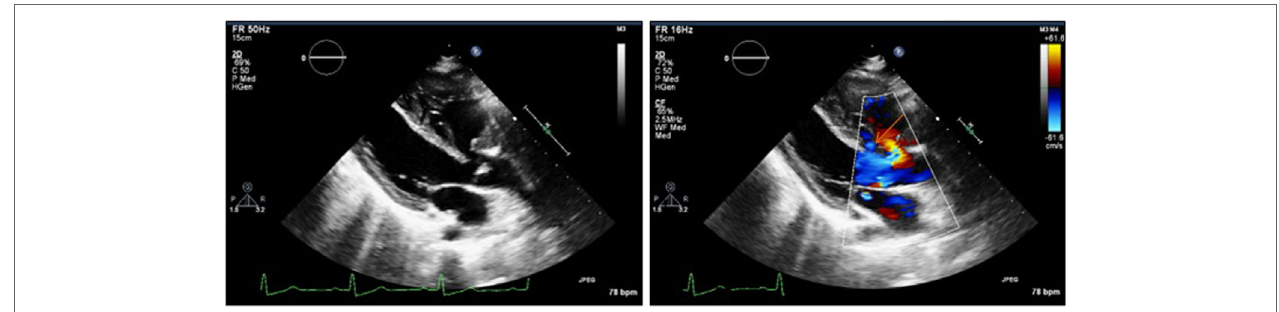
FIgURe 1 | Preoperative transthoracic echocardiogram showing a membranous ventricular septal defect with predominant right to left shunting (see orange arrow).